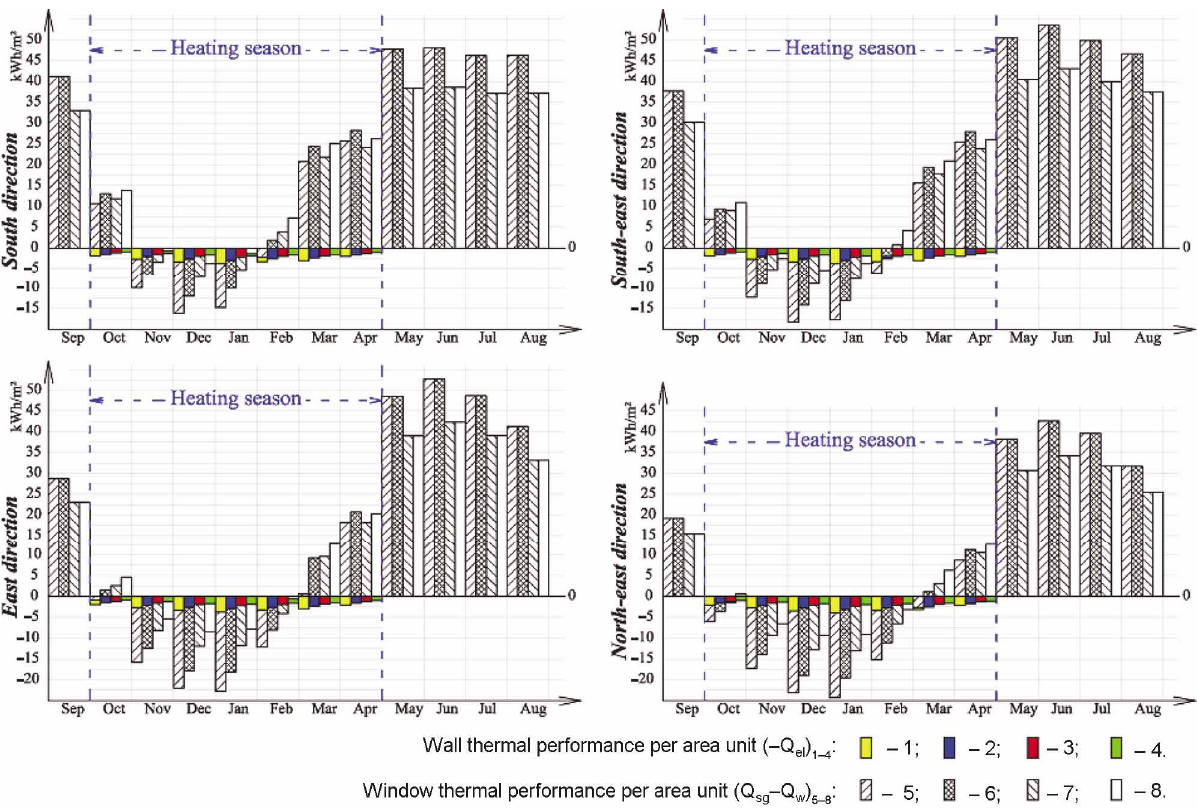
Fig. 3. Representation of the energy balance of windows and walls per area of 1 m 2 oriented to S, S-E, E, N-E: Q sg – solar gains per window area unit; Q w – heat losses per window area unit; Q el – heat losses per wall area unit